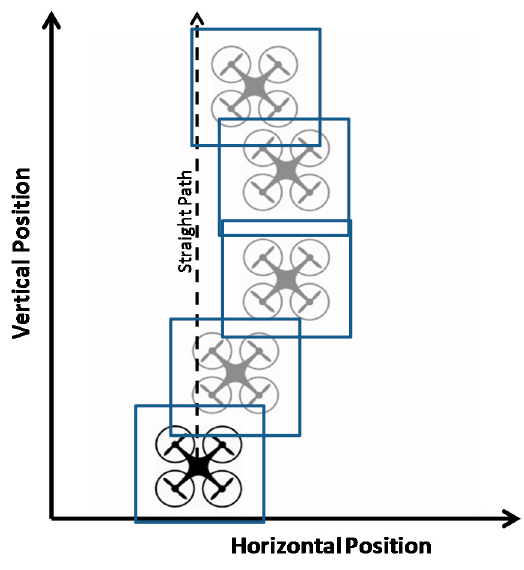
Figure 6. Concept of rectilinear motion test evaluation using image processing.